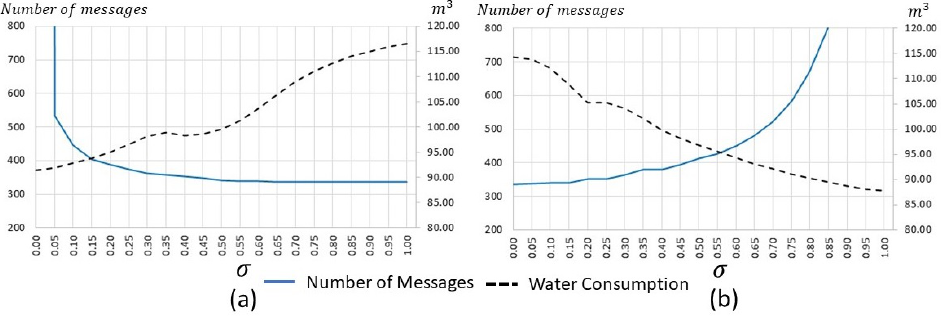
Figure 6. Estimated transmitted messages and water consumption: ( a ) Error-based triggering condition γ 1 . ( b ) Lyapunov-based triggering condition γ 2